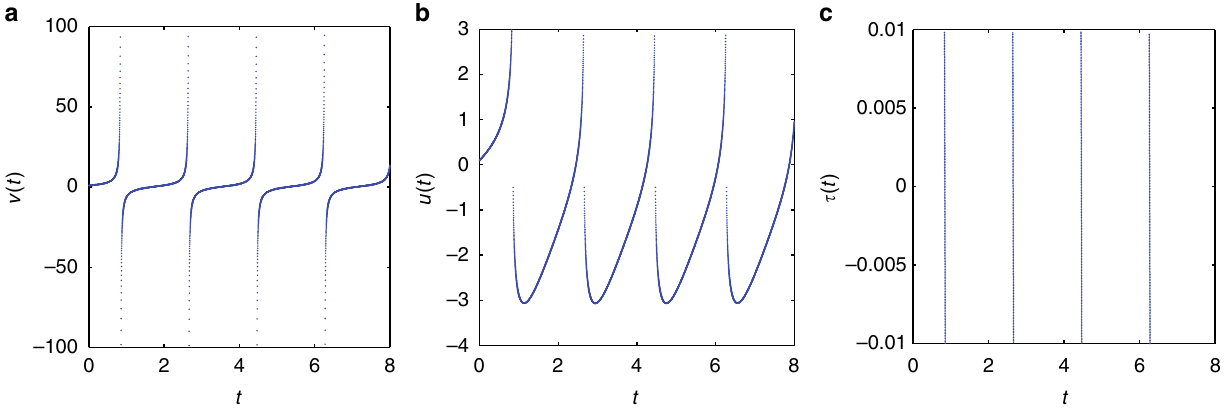
Fig. 8 Passing in fi nity numerically for the 2D quadratic integrate-and- fi re neuronal model. Repeatedly: a , b integrate Eq. (54) until ν suf fi ciently approaches blowup, c integrate the transformed Eq. (55) to pass smoothly through 0. Here we show the dynamics of the singular transformation r = 1/ ρ . For our simulations, we have set b = 1, I = 1, initial conditions ν (0) = 1, u (0) = 0.1; time integration was performed again using the ode23s matlab solver 55 with Relative tolerance = 1. E − 08 and absolute tolerance = 1. E − 08